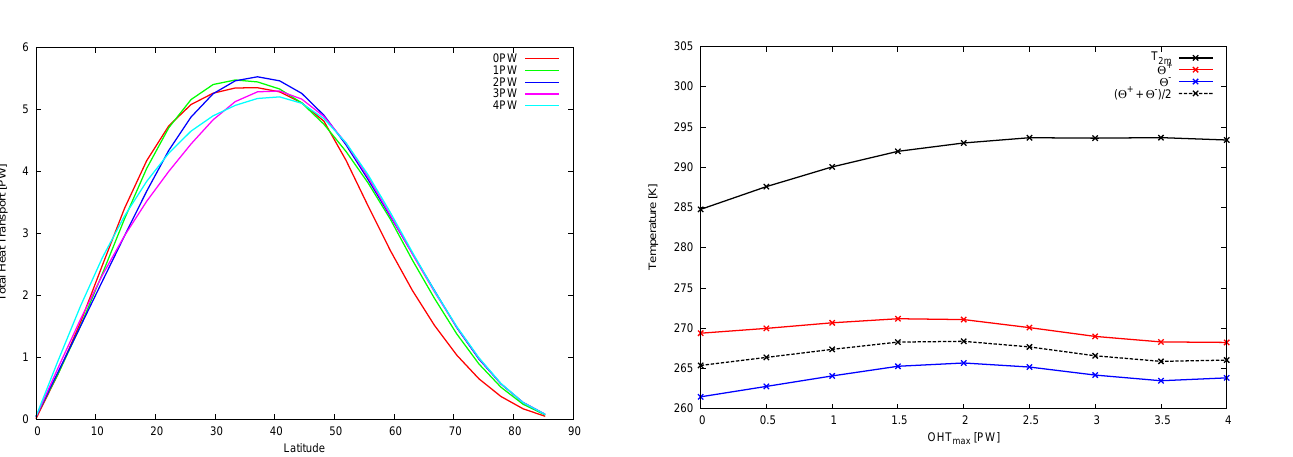
ture T M and of the temperature of the warm ( (cid:50) + ) and the cold ( (cid:50) − )